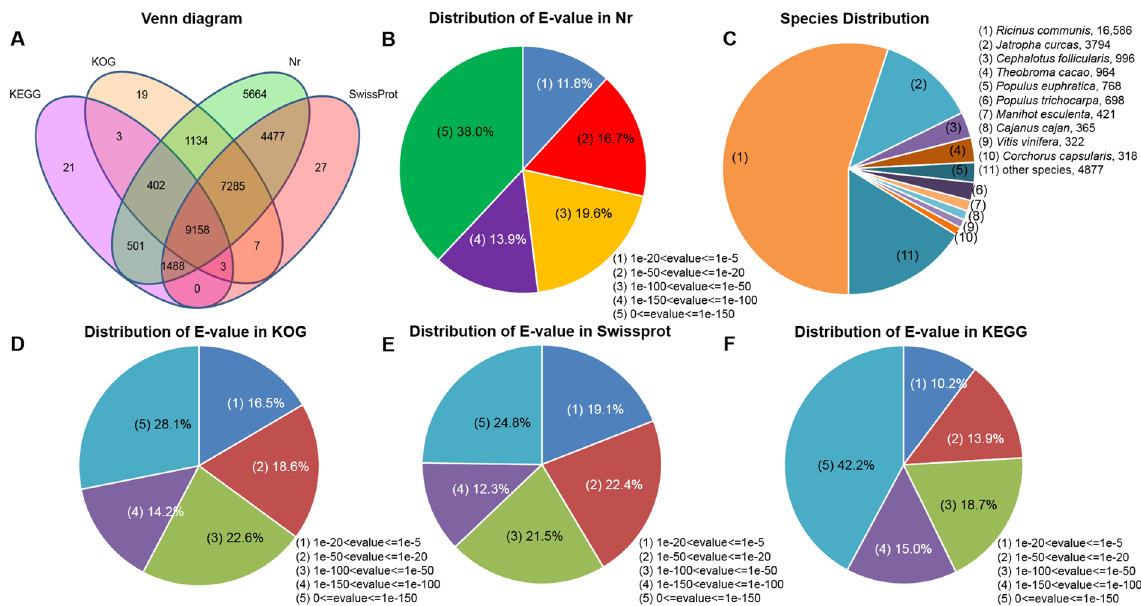
Figure 2. Characteristics of homology searches of sacha inchi unigenes: ( A ) Venn diagram of number of unigenes annotated by BLASTx with a cut-off value of 1e−5 against protein databases, with encircled numbers indicating the number of unigenes annotated by single or multiple databases; ( B – F ) E-value distribution of the top BLASTx hits against the Nr, KOG, Swissprot and KEGG databases respectively; and, ( C ) number of unigenes matching the 10 top species using BLASTx in the Nr